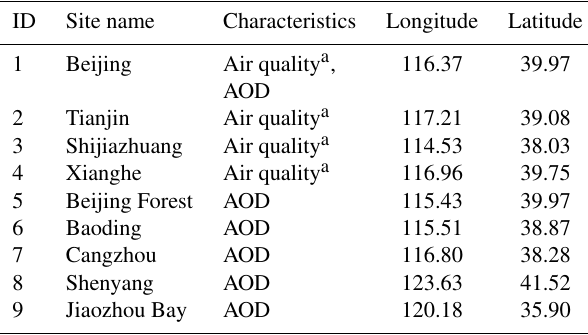
Table 2. CARE-China network